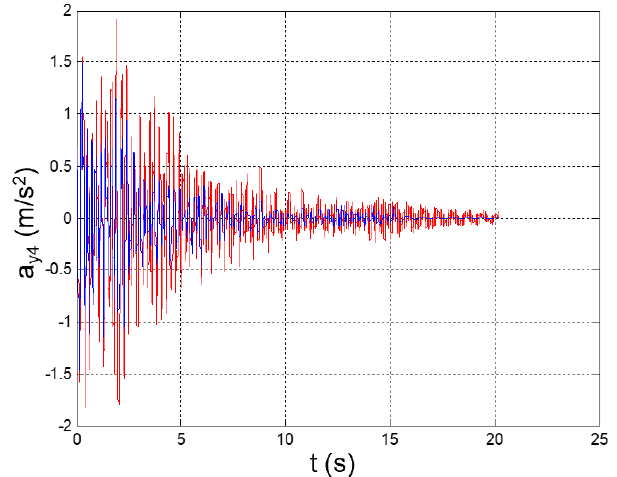
Figure 29. Seismic response, 4th-floor acceleration (Node 48) with respect to the ground.